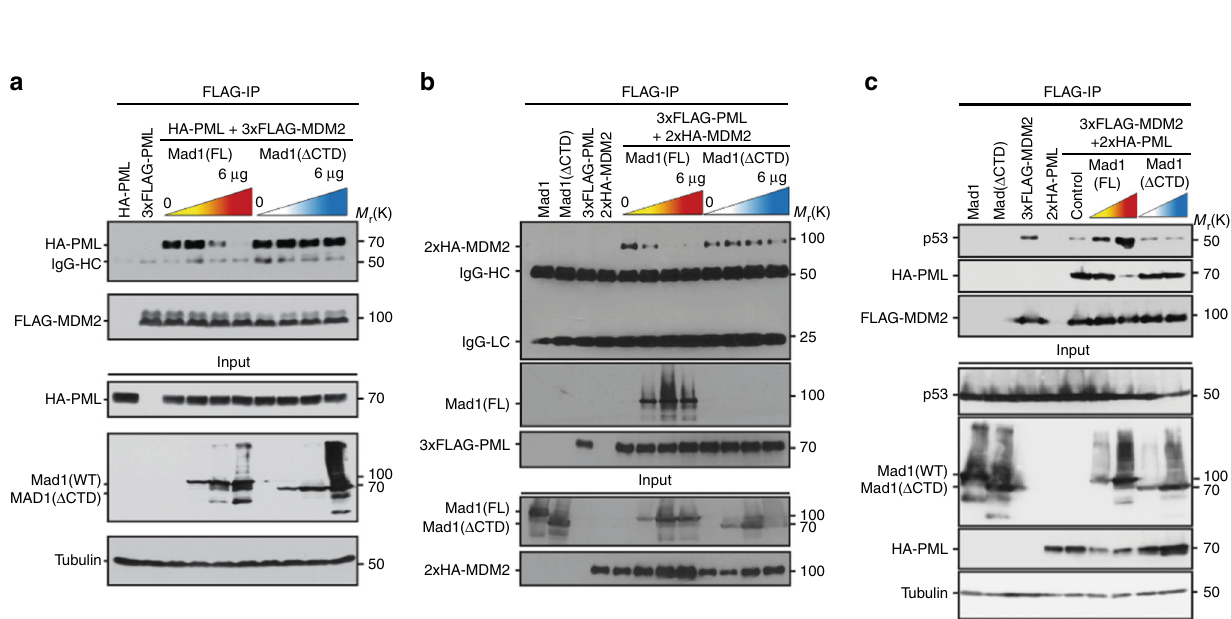
Fig. 6 Upregulation of Mad1 prevents the interaction between MDM2 and PML, freeing MDM2 to bind p53. a Increased expression of full length (FL) Mad1 but not Mad1 lacking the CTD (aa 1 – 596; Mad1 Δ CTD) impairs co-immunoprecipitation of PML with MDM2. 293T cells were co-transfected with HA-PML, 3xFLAG-MDM2, and increasing amounts of FL Mad1 or Mad1 Δ CTD. b Reciprocal experiment showing that increased expression of FL Mad1 but not Mad1 Δ CTD impairs co-precipitation of MDM2 with PML. 293T cells were co-transfected with 3xFLAG-PML, 2xHA-MDM2, and increasing amounts of FL Mad1 or Mad1 Δ CTD. c Upregulation of Mad1 inhibits the interaction of MDM2 with PML, freeing MDM2 to interact with p53. 293T cells were co- transfected with 2xHA-PML, 3xFLAG-MDM2, and increasing amounts of FL Mad1 or Mad1 Δ CTD. a – c 48 h after transfection, cell extracts were prepared and immunoprecipitated using beads coupled to anti-FLAG antibodies. Blots are representative of 3 independent